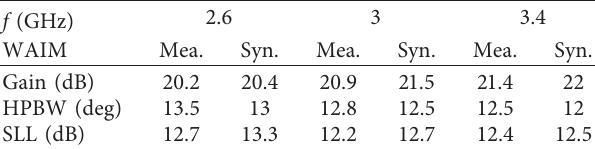
Figure 15: Measured radiation pattern ( H -plane) of the antenna array. Table 4: Comparison of measured results and synthesis results (0 ° ).